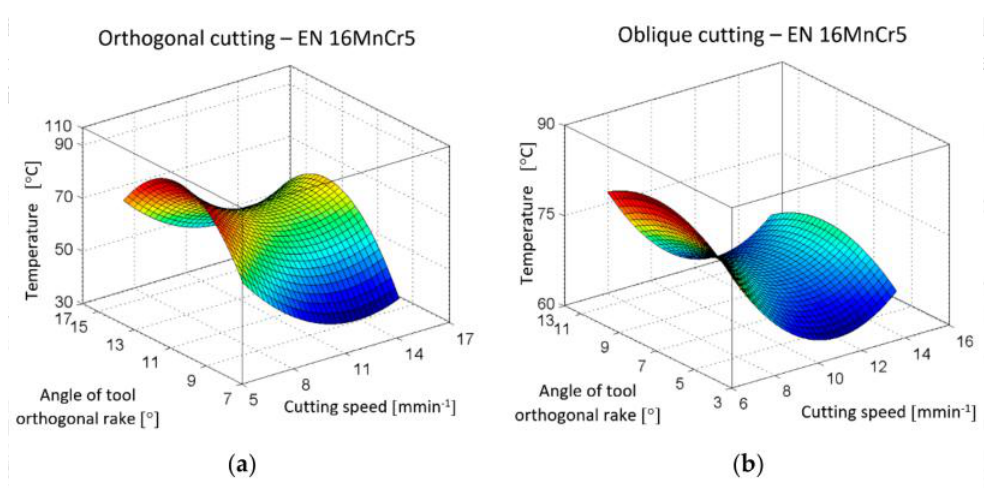
Figure 9. The dependence of temperature T on cutting speed v c and angle of tool orthogonal rake γ o .